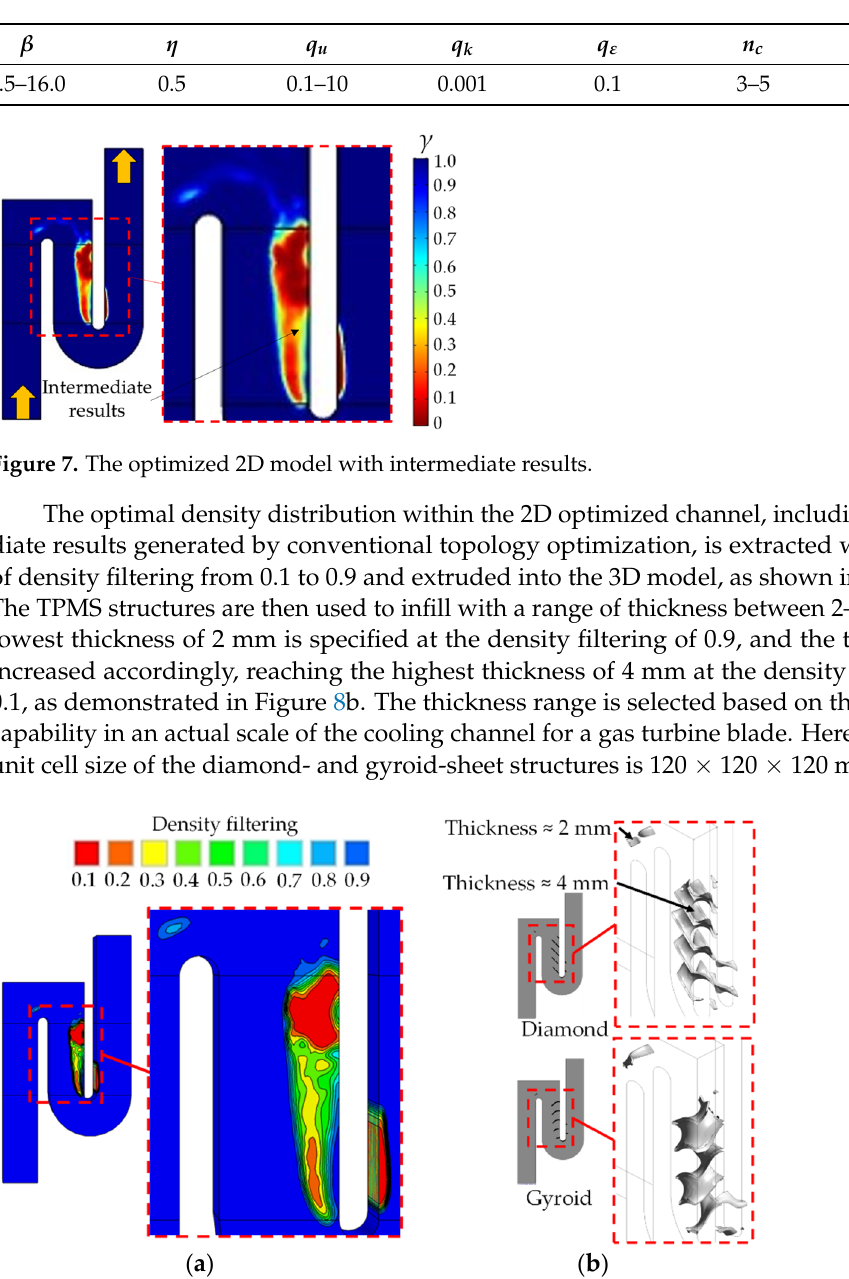
( c ) Figure 9. Models for comparison: ( a ) optimized model extracted with density filtering of 0.5 (TO model); ( b ) optimized model infilled with diamond ‐ sheet structure (TO model with diamond ‐ TPMS); ( c ) optimized model infilled with diamond ‐ sheet structure (TO model with gyroid ‐ TPMS). The flow and heat transfer for all models in this section are simulated using the com ‐ mercial CFD solver ANSYS FLUENT 18.0, which provides lower computational costs and consumes lesser computer memory for 3D complex cooling channels than COMSOL. The overview of mesh systems for the optimized model with the diamond ‐ sheet structure is demonstrated as an example in Figure 10. The hybrid mesh involving tetrahedron and prism elements is created to discretize the entire domain. The tetrahedron meshes are